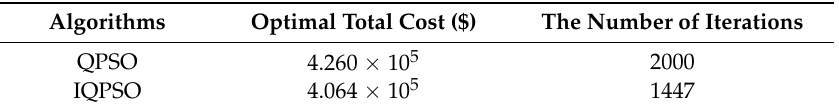
Table 2. Optimal total cost of the two algorithms.